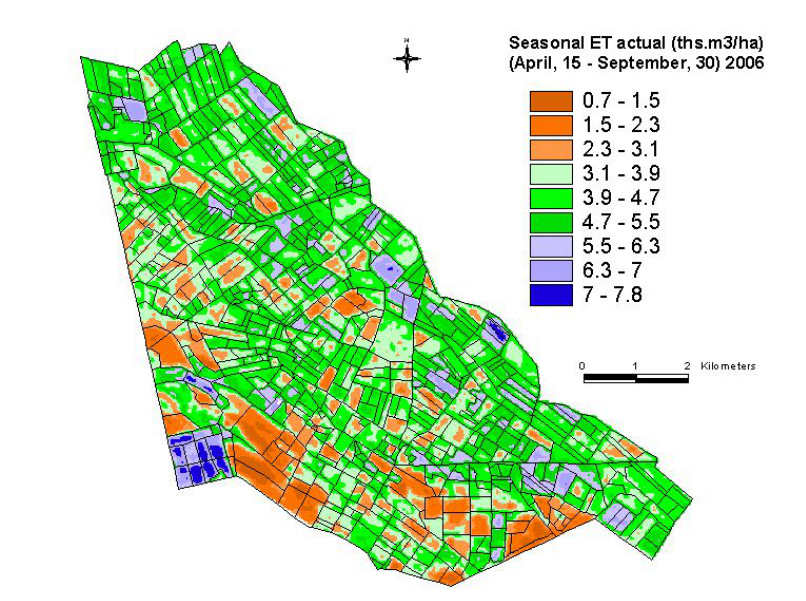
Figure 12. Actual seasonal evapotranspiration (ET cotton growing period of year 2006.